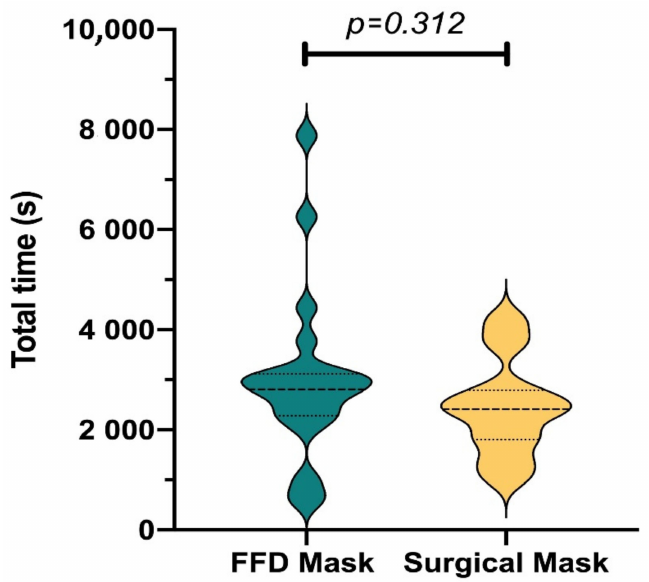
Figure 3. Total time needed to reach proficiency in the laparoscopic knot tying task. s, second. For the laparoscopic cholecystectomy task, the medians of the global OSATS scores, with the highest possible score being 35, were not significantly different (snorkel mask 25 (IQR 22.5–26.3) vs. surgical mask 27 (IQR 23.3–28.0); p = 0.259). The medians of the task-specific OSATS scores, with the highest possible score being 70, were not signifi- cantly different either (41.0 (IQR 37.5–48.5) and 51.0 (IQR 33.5–56.0); p = 0.290) (Figure 4). There was no difference in mean time for cholecystectomy between groups (FFD mask